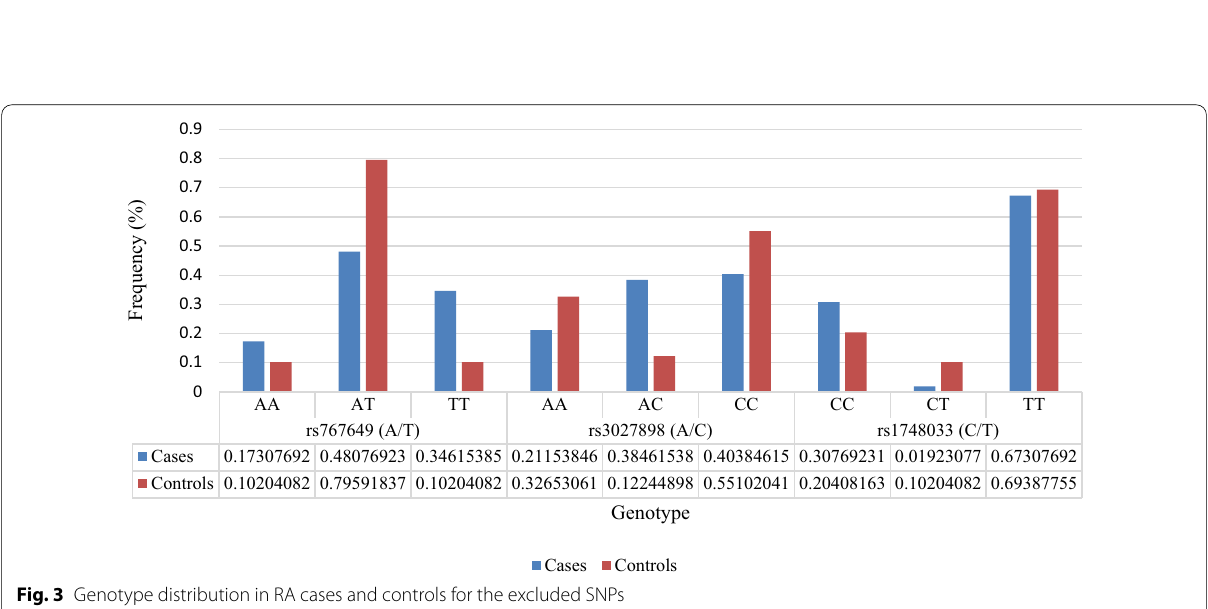
Fig. 3 Genotype distribution in RA cases and controls for the excluded